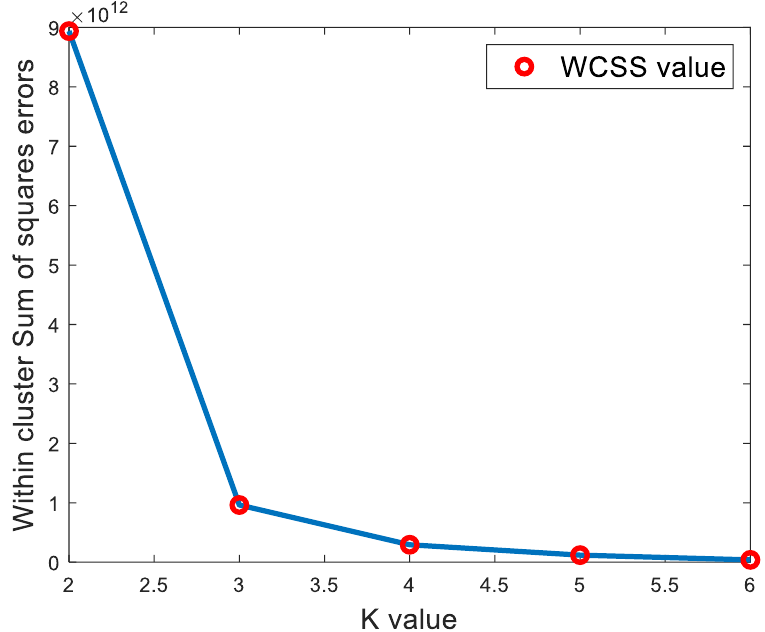
Figure 8. The Elbow method for optimizing clusters.